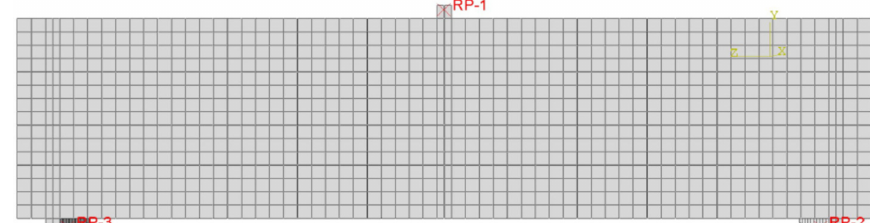
Figure 4. Boundary condition for the simulated